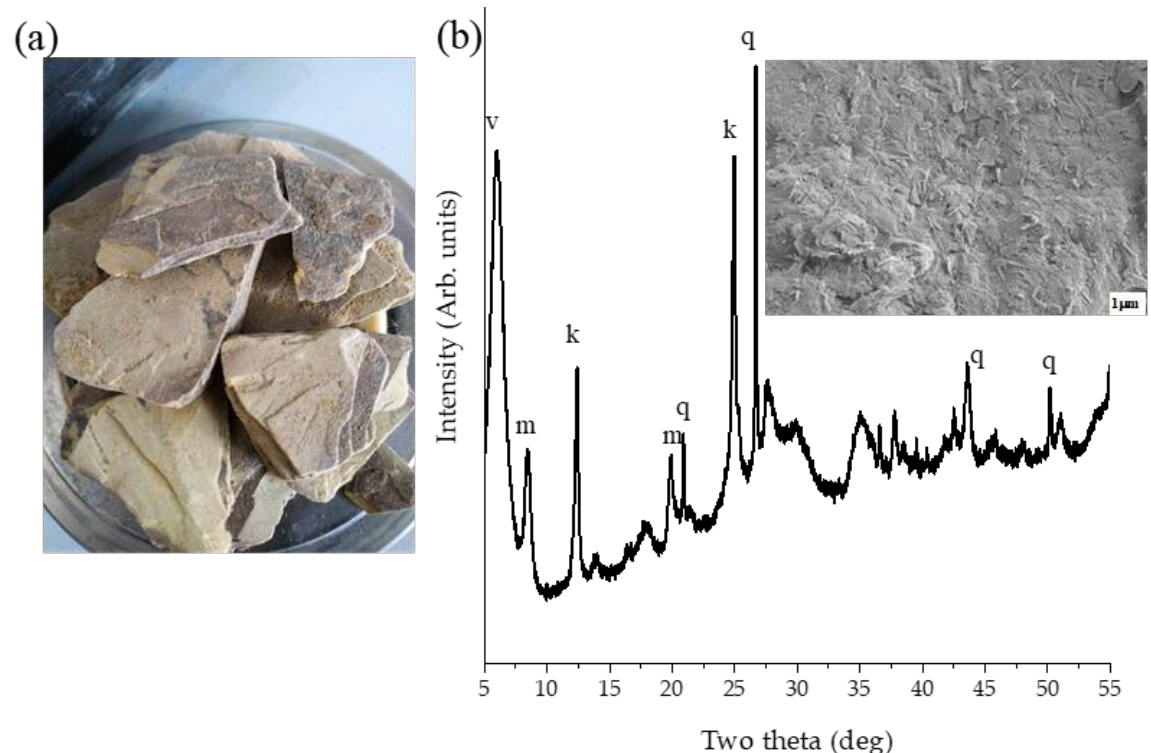
Figure 1. ( a ) Raw vermiculite-kaolinite clay (VK) and ( b ) phase identification and micrograph of VK.k kaolinite, m muscovite, v vermiculite, and q quartz. Insert contains an SEM image.